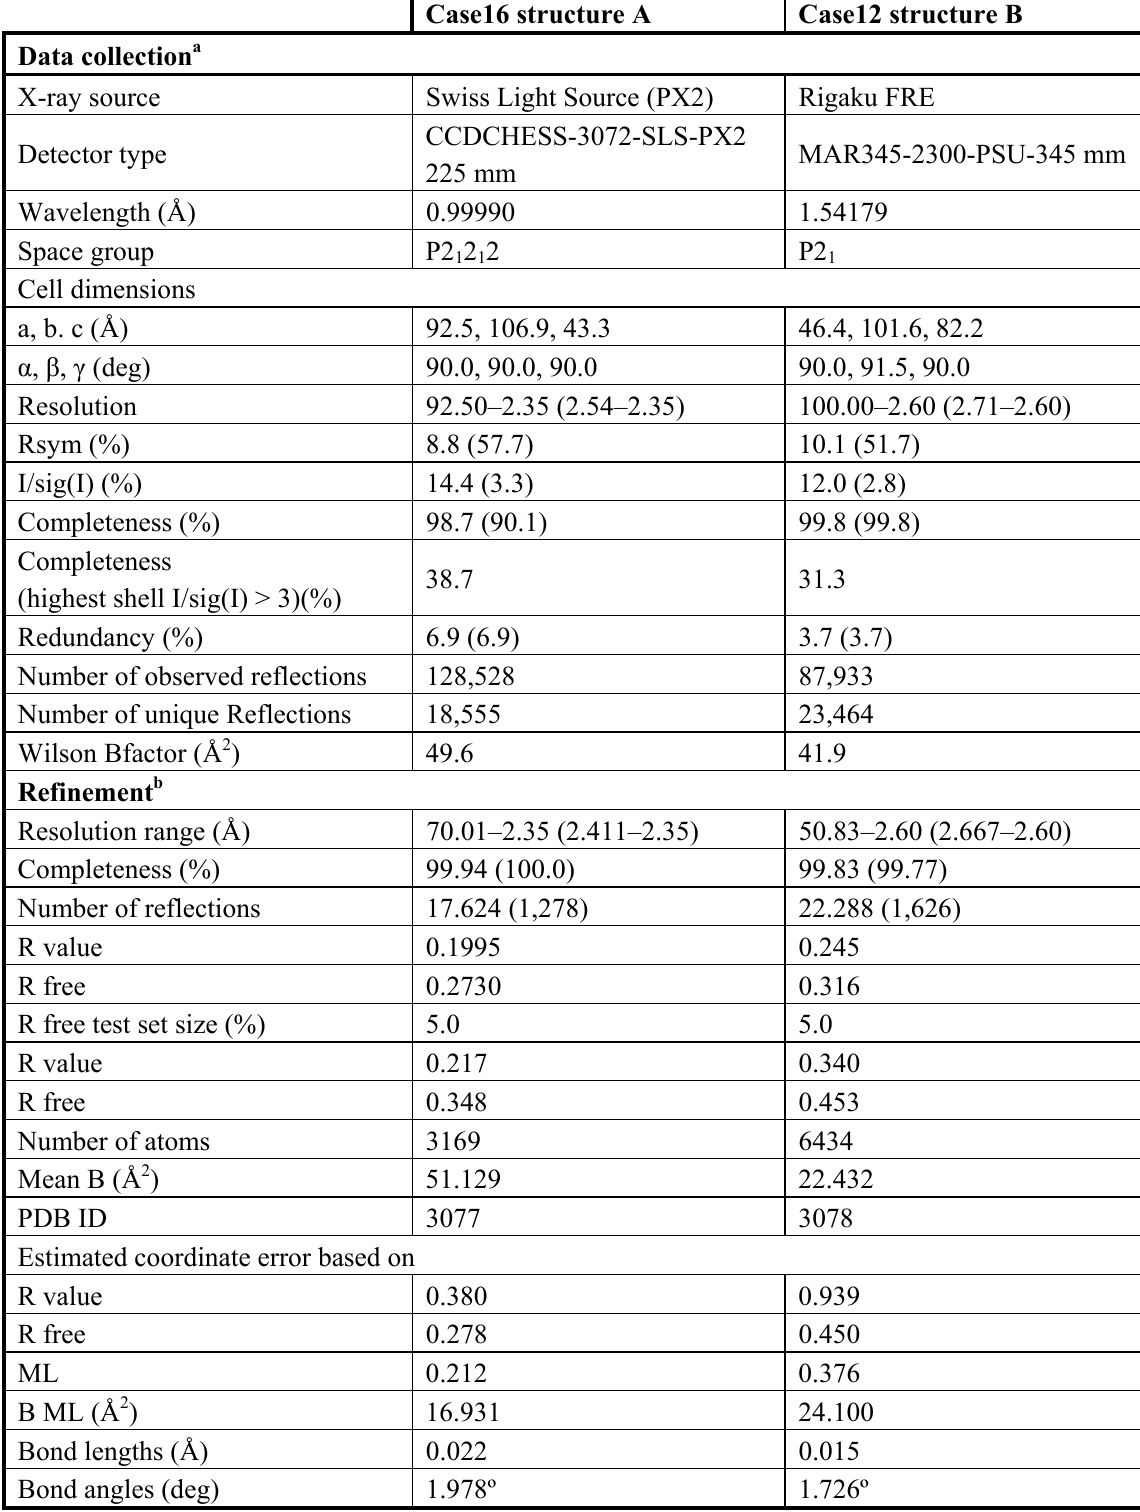
Table 1. Data collection and refinement